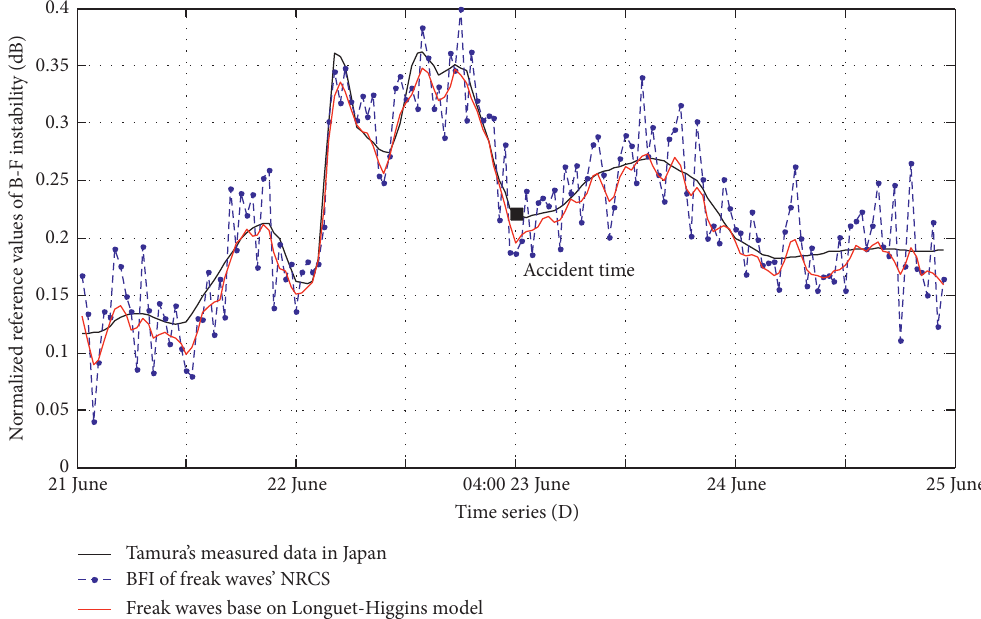
Figure 14: Comparison of B-F instability of Longuet-Higgins simulation result and freak wave measured in Tokai,